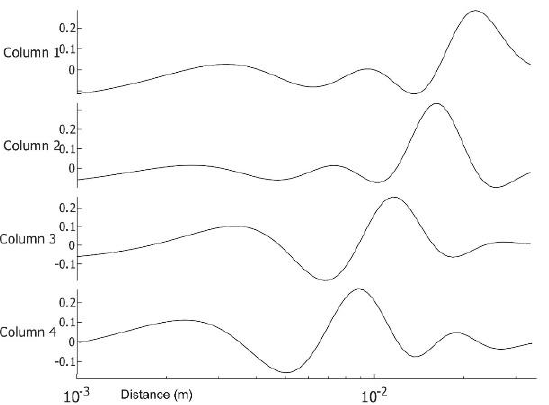
Figure 5. Traces 1:4 after application of ICA to the time matrix of Figure 3 on log time scale with the sequence t i = 0.025 × 2 ( i − 100)/20 .